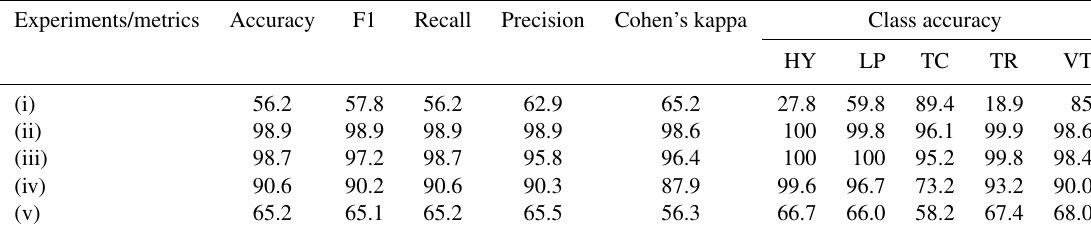
Table 4. Performance of the transfer learning experiments to 1–10 [Hz]. Experiments/metrics